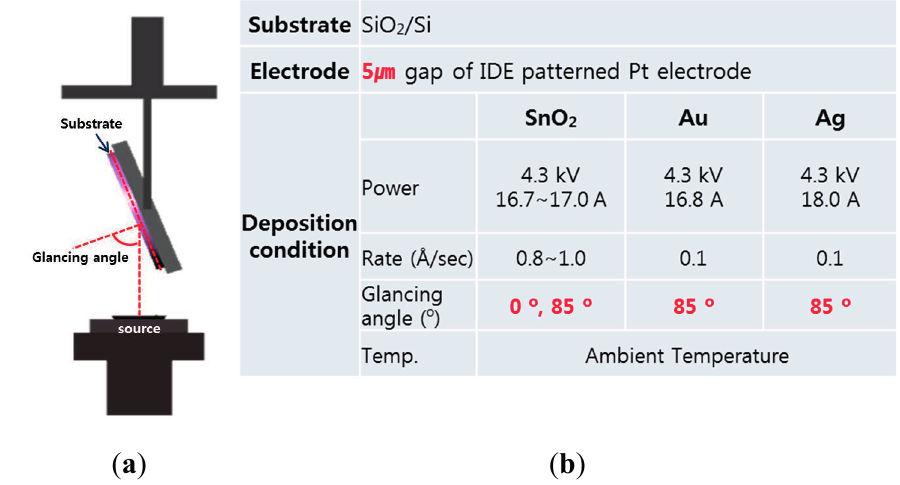
Figure 1. ( a ) A schematic diagram of the e-beam evaporation using the glancing angle deposition technique; ( b ) Deposition condition of the